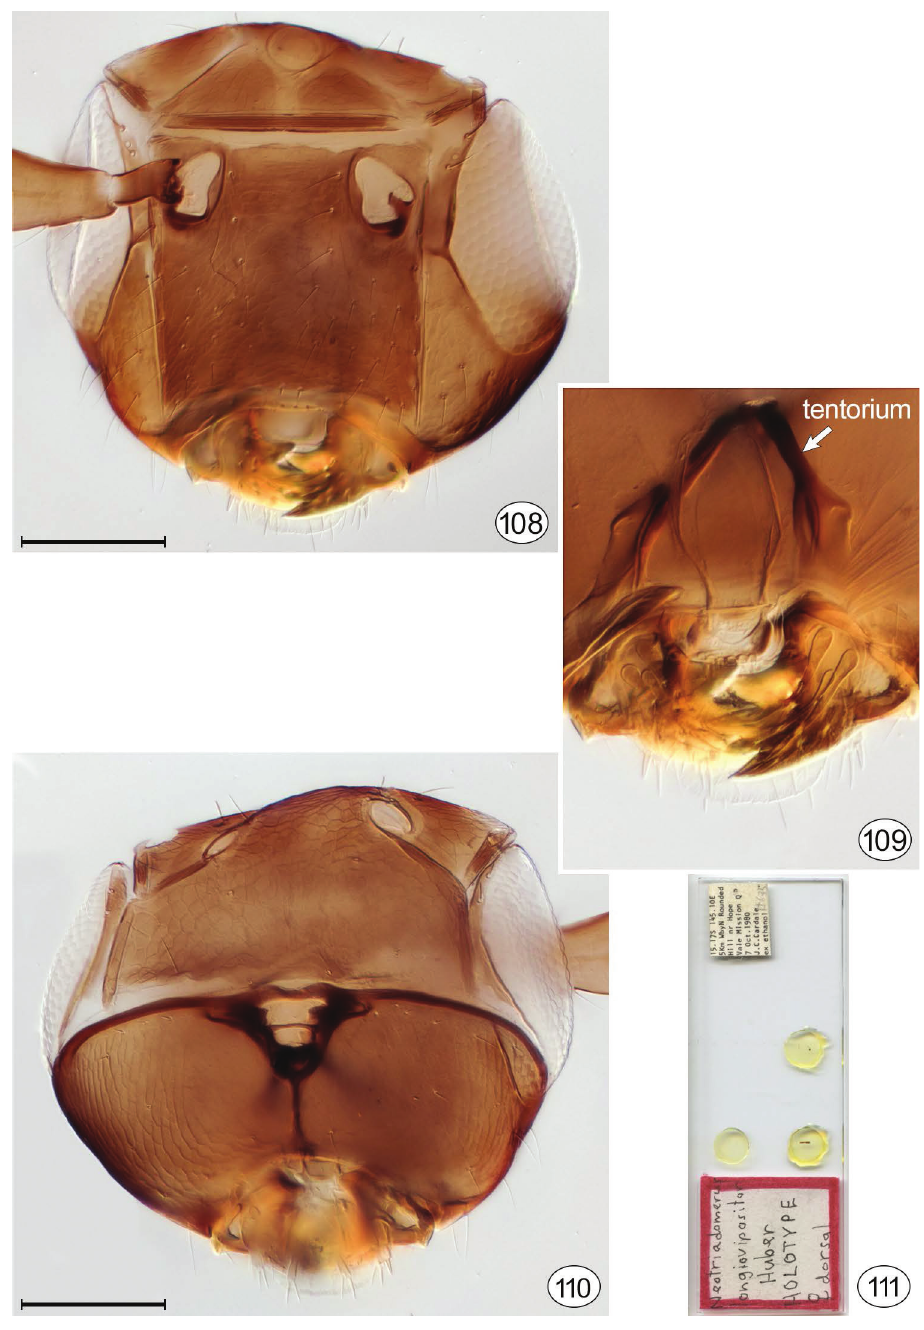
Figures 108–111. Neotriadomerus longiovipositor , holotype. 108 head, anterior 109 mouthparts and tentorium 110 head, posterior 111 holotype slide. Scale bar = 200